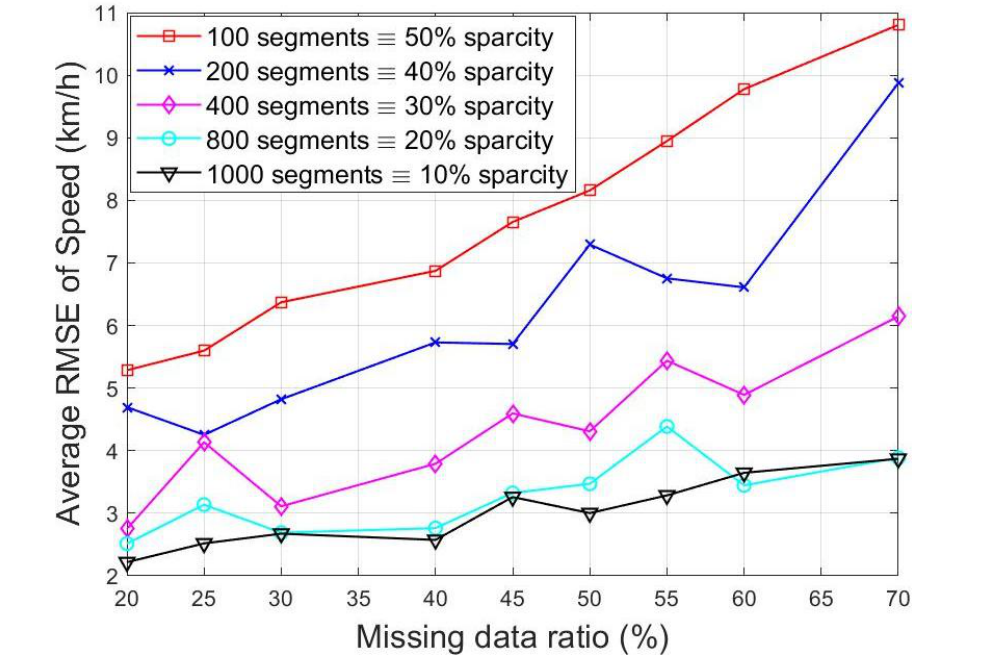
Figure 5. RMSE of speed at different missing data ratios.